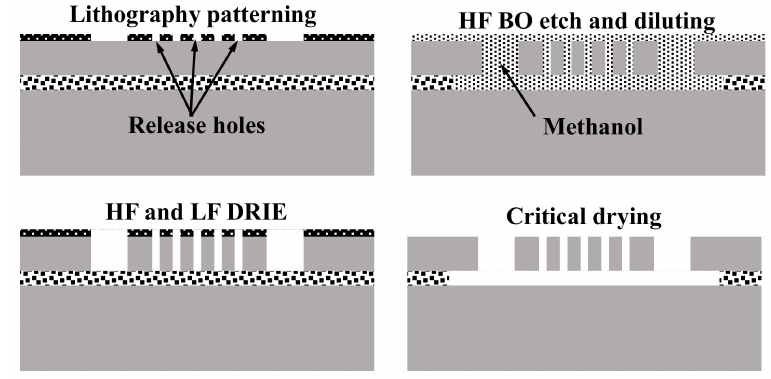
Figure 7. Simplified fabrication process of test comb drive microstructures.